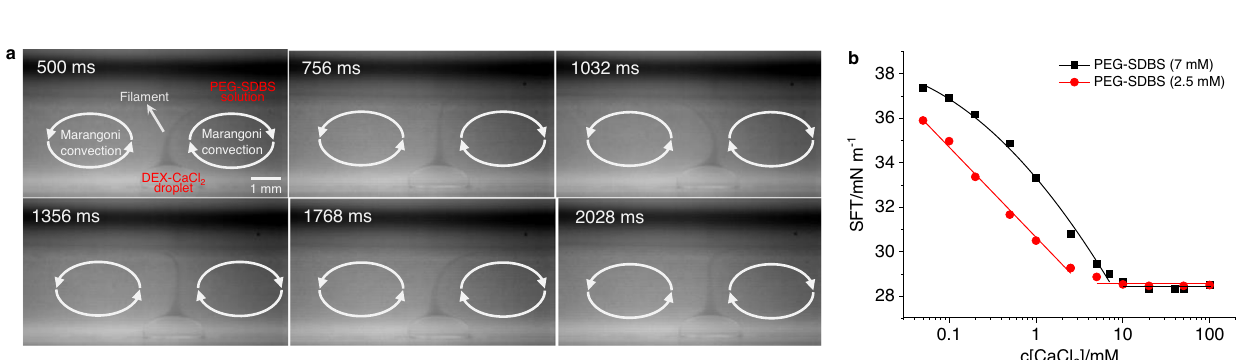
Marangoni convection. b Marangoni transport from a droplet to the bulk solution surface (by Marangoni convection), and then at the air/water interface (by Mar- angoni effect).